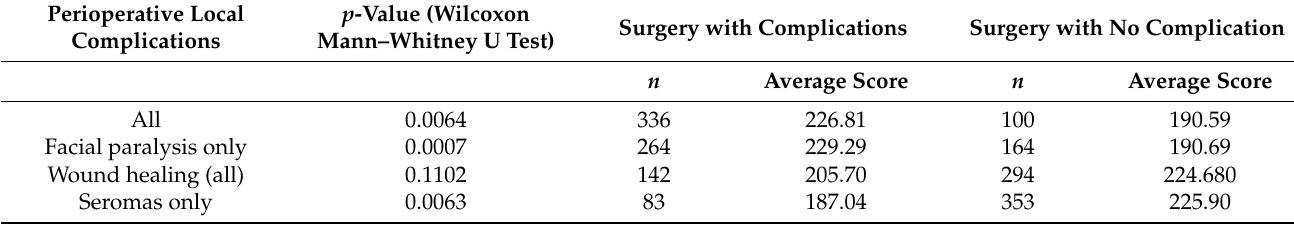
Table 9. Non-parametric Mann–Whitney U test comparing lengths of hospital stays between parotidectomies with and without perioperative complications. All = overall complications ( n = 436: analysis of all complications, wound healing disorders and seromas; n = 428: analysis of facial paralysis